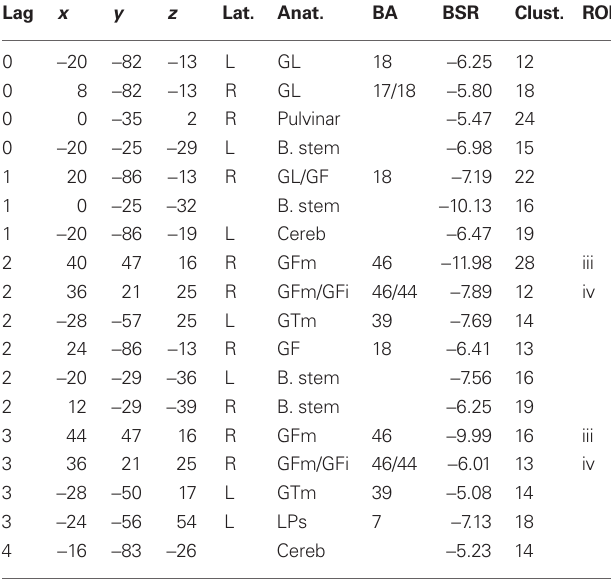
Cluster thresholding criteria as in Table 2. All abbreviations as in Tables 1 and 2.